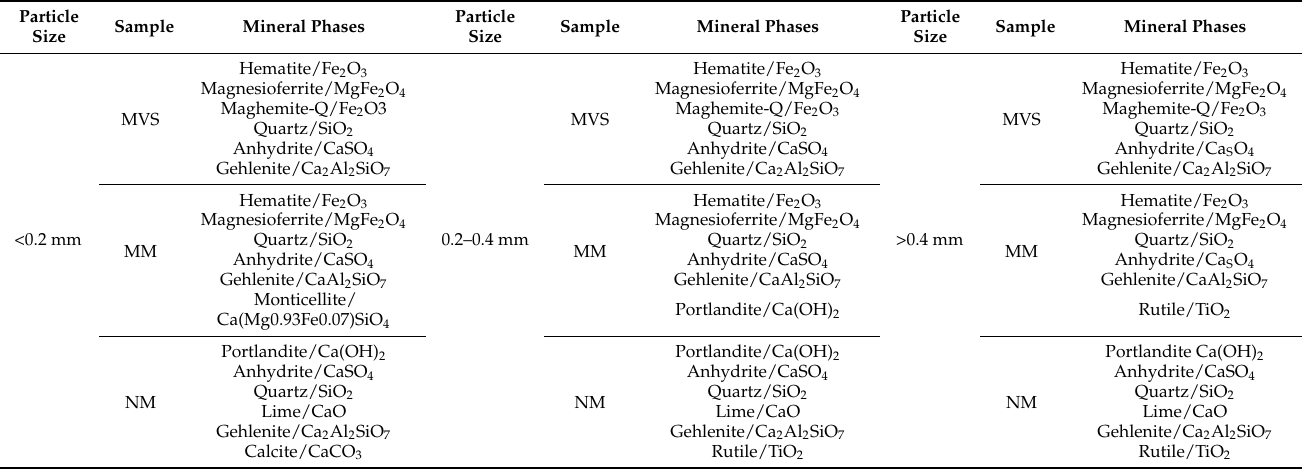
Table 2. Mineral phases identified in the studied magnetic and non-magnetic fractions (MVS = magnetic vibrofluidized state, MM = magnetic manually, NM =